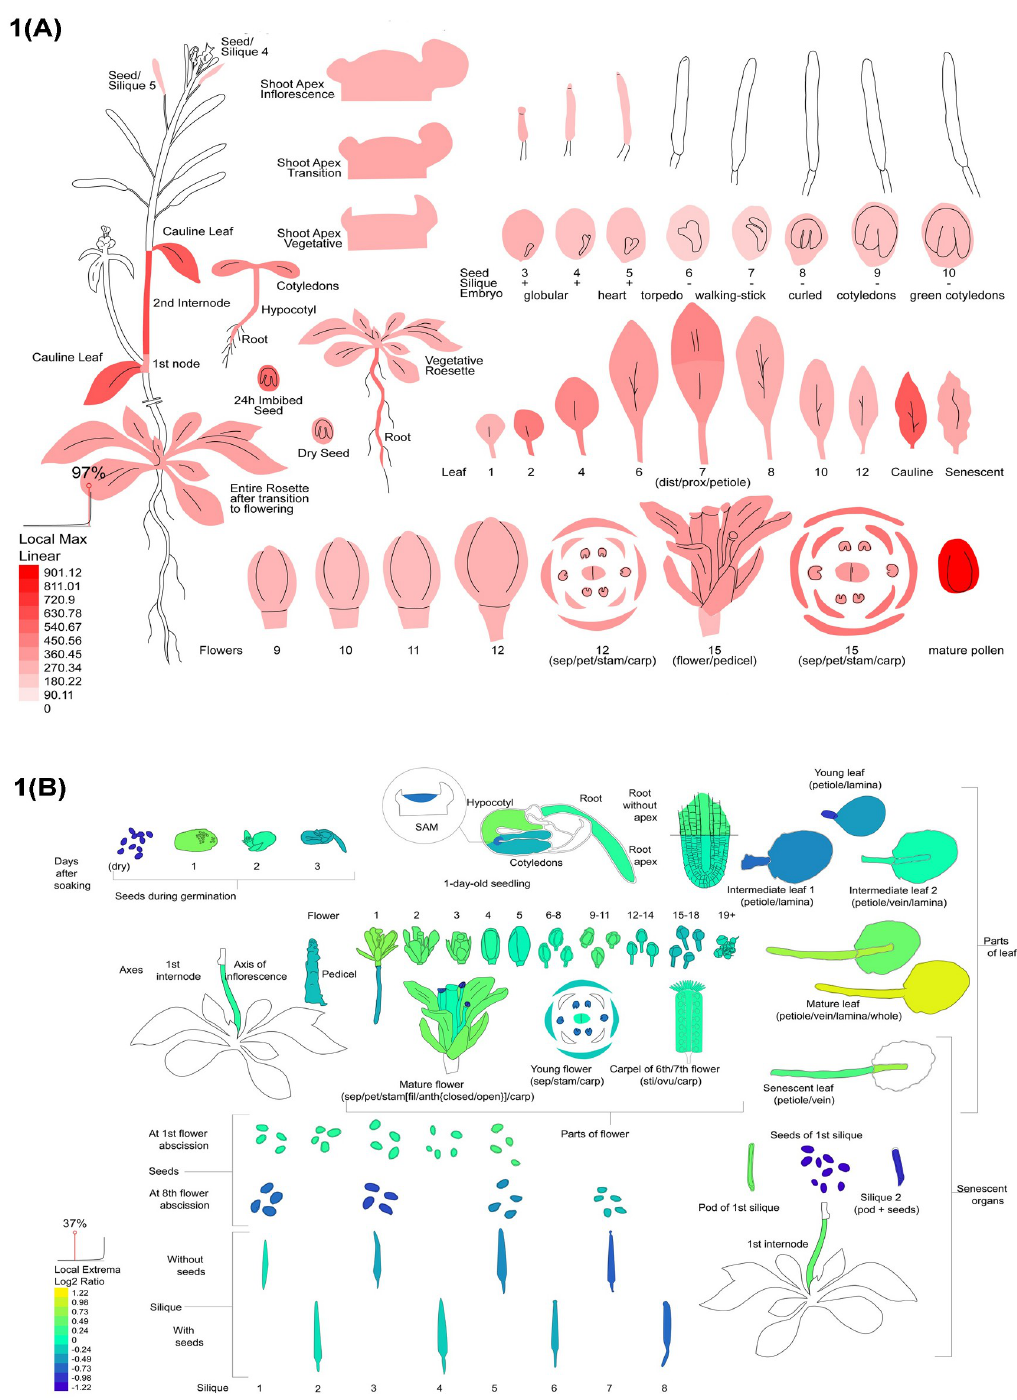
Fig 1. RNA-Seq data and developmental transcriptome expression. A: ACD11 gene expression in developmental transcriptomics. B: ACD11 gene expression in RNA-Seq transcriptomics.